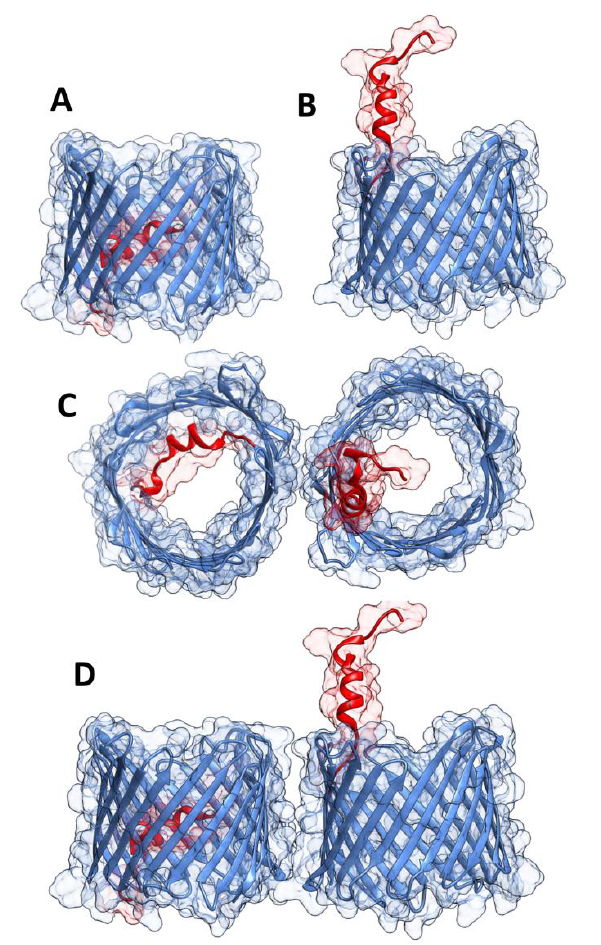
FIGURE 1: Three-dimensional structure of VDAC1. VDAC1 mon- omer and dimer structures. (A) Side-view of the crystal structure of VDAC1 (PDB code: 3EMN). The β-barrel is formed by 19 β strands and the N-terminal domain (colored red) is folded into the pore interior. (B) A proposed model for the conformation of VDAC1 with its N-terminal on the outside of the VDAC1 pore. (C) Top-view of VDAC1 dimer with the N-terminal helix nested inside the VDAC1 pore in one monomer and outside of the pore in the other. (D) Side-view of proposed dimer of VDAC1. Figures were prepared using PyMOL